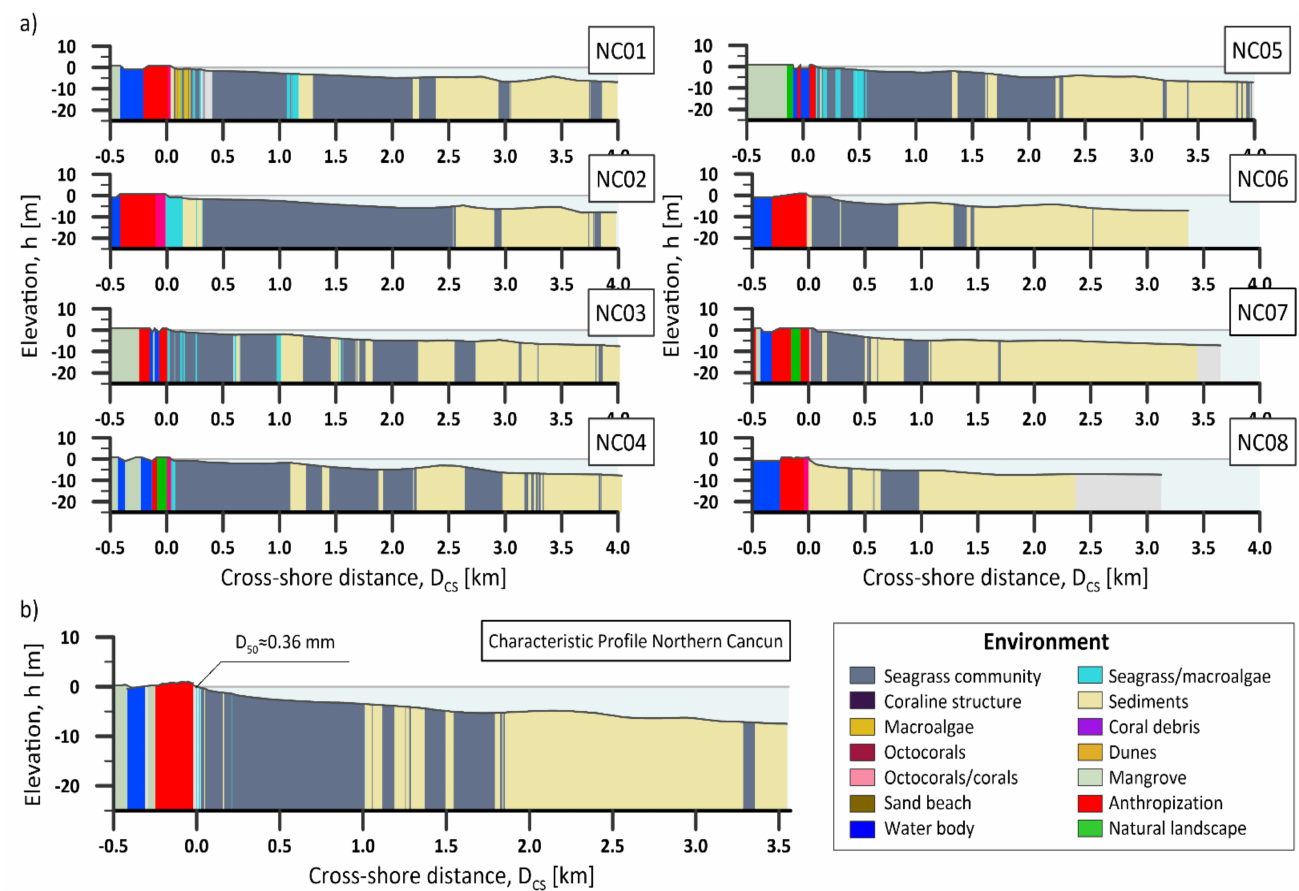
Figure 6. Beach profiles in northern Cancun, extending from 500 m inland, and up to 4 km seaward. The shoreline is located at a cross-shore distance D C S = 0 m. The profiles ( a ) are numbered as in Figure 1. The land use for northern Cancun ( b ) corresponds to profiles NC01-NC08. Almost all the coastal profiles at Cancun show sandy beaches, except NC03 and